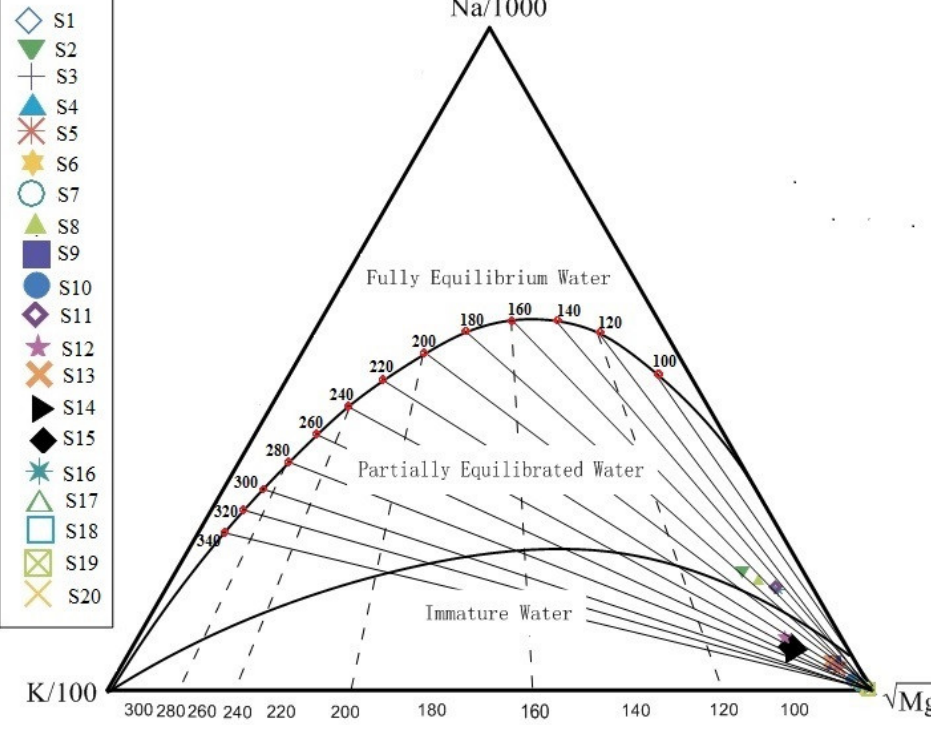
Figure 9. Distribution of aqueous samples on the Na/1000-K/100-Mg1/2 ternary diagram.